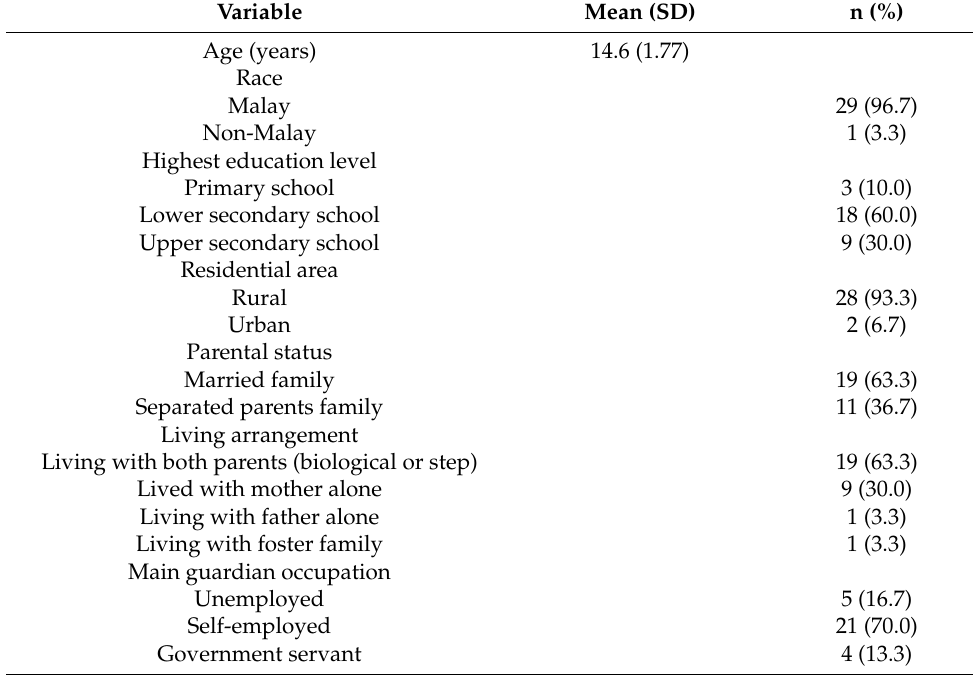
Table 2. Sociodemographic characteristics of sexual abuse victims ( n =